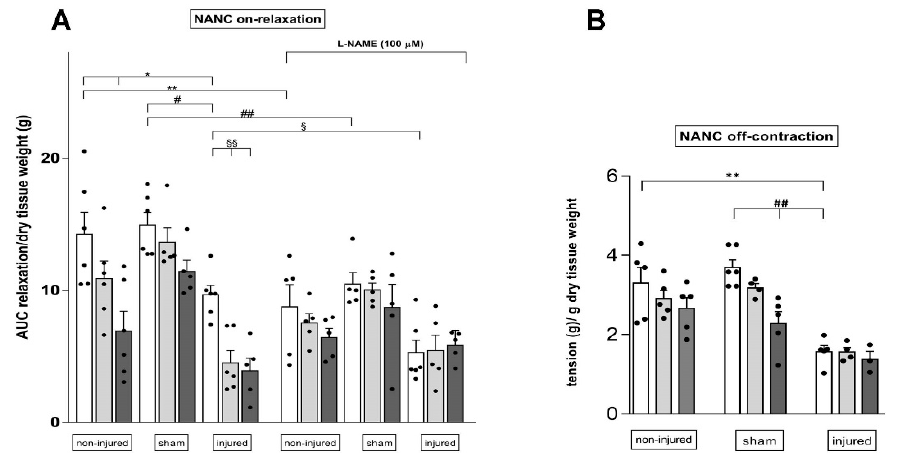
Figure 9. Blockade of TLR2/4 receptors reduces NANC on-relaxations and does not influence off-contractions in the rat small intestine after IRI injury. ( A ) Ten hertz EFS-evoked NANC on-relaxation responses of the rat small intestine longitudinal muscle in non-injured, sham-operated and injured groups in the absence (white columns) and presence of Sparstolonin B (SsnB) 10 µM (light grey columns) and 30 µM (dark grey columns). Some experiments were conducted in the presence of L-NAME 100 µM. ( B ) Tachykinergic-mediated contractions evoked by 10 Hz EFS in small intestine segments under NANC conditions, in the presence of L-NAME. Data are reported as mean ± SEM. N = 5 rats/group. Statistical significance: * ,#,§ p < 0.05, ** ,##,§§ p < 0.01 by one-way ANOVA followed by Tukey’s post hoc test.